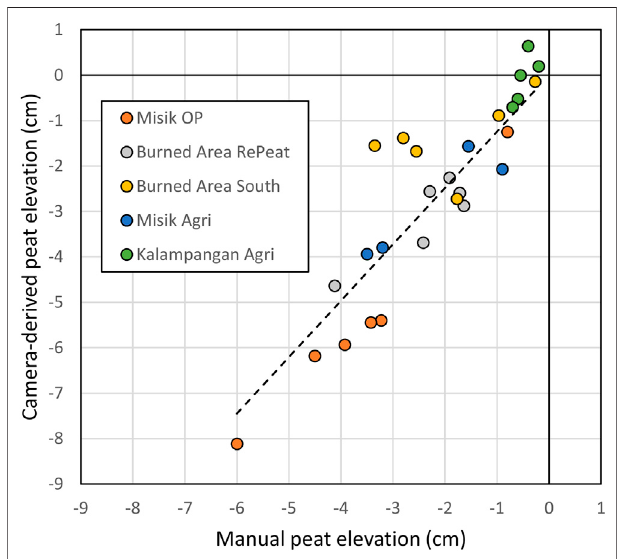
FIGURE 7 | Camera-derived vs. manual elevation data for fi ve sites with near-continuous records, relative to a zero datum value at the time of the fi rst manual measurement.